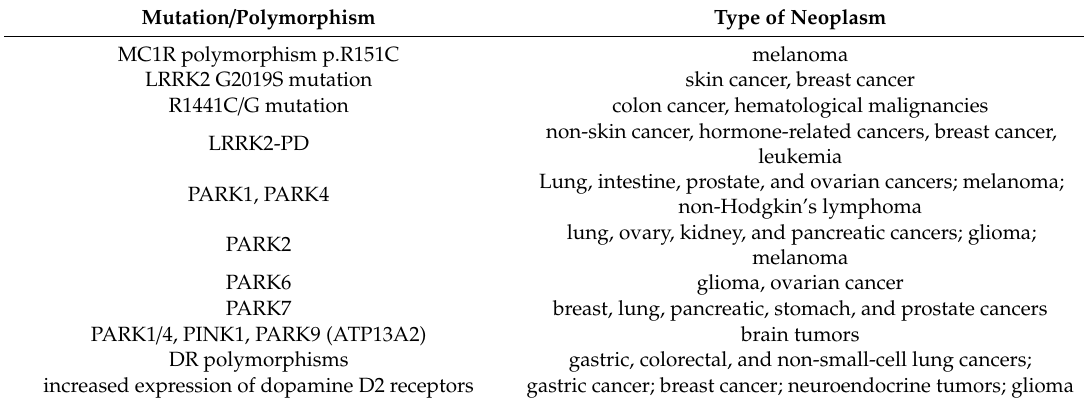
Table 1. Genetic mutations and polymorphisms associated with di ff erent malignancies and found in Parkinson’s disease (PD)